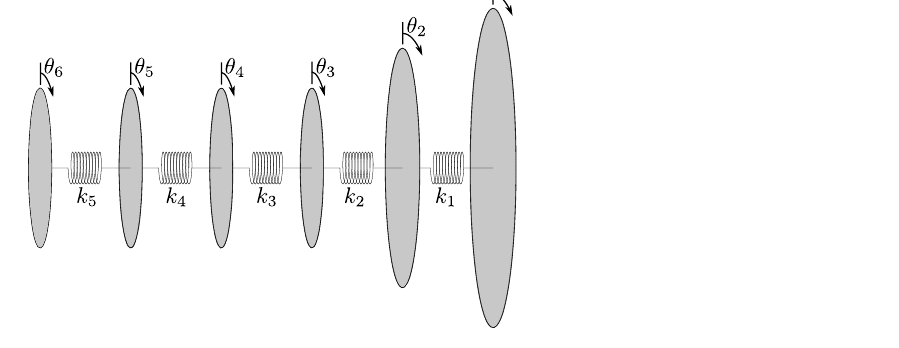
Figure 4. Schematic of the spring-disc TRPT representation. Each ring is described by a moment of inertia, J , and the multiple tethers in each section are replaced by a single torsional spring of stiffness k . Disc 6, on the left hand side of the schematic, represents the ground-station end of the TRPT.